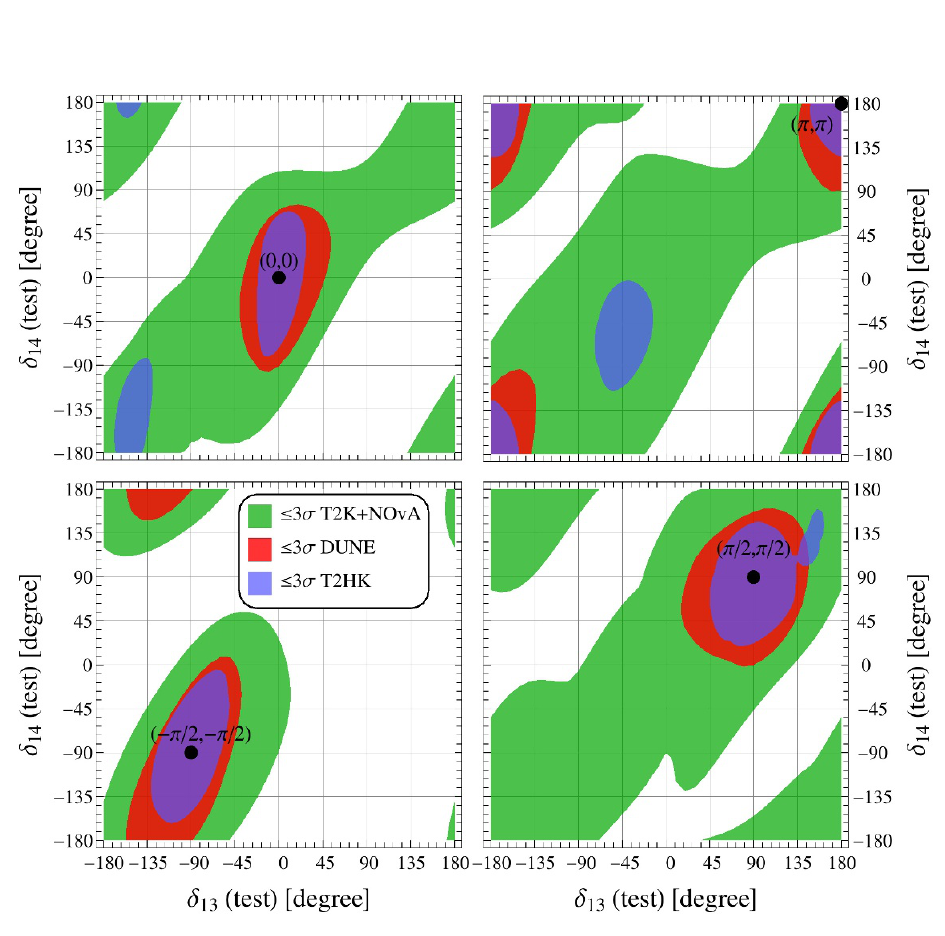
Figure 8 . Reconstructed regions for the two CP phases (cid:14) 13 and (cid:14) 14 for three di(cid:11)erent experimental setups. We have taken the NH as the true hierarchy and we have marginalized over the two possible hierarchies in the test model. The contours correspond to the 3 (cid:27)